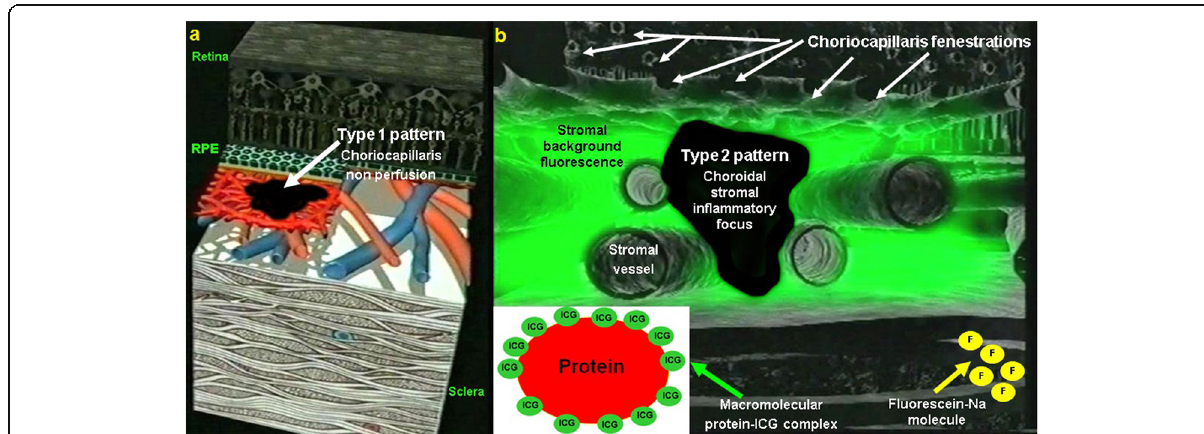
Fig. 3 Indocyanine green angiography (ICGA) patterns in non-infectious choroiditis. Two main patterns have been identified in choroiditis. Pattern 1 is generated in inflammatory choriocapillaris non-perfusion (a). Pattern 2 is found in stromal inflammation when foci develop and impair the diffusion of the ICG-protein complex shedding from the fenestrated choriocapillaris (b). The ICG-protein complex is shown in the insert, which is much larger than the fluorescein molecule with a slow wash-out from the choroid. (Reprinted from reference 8)